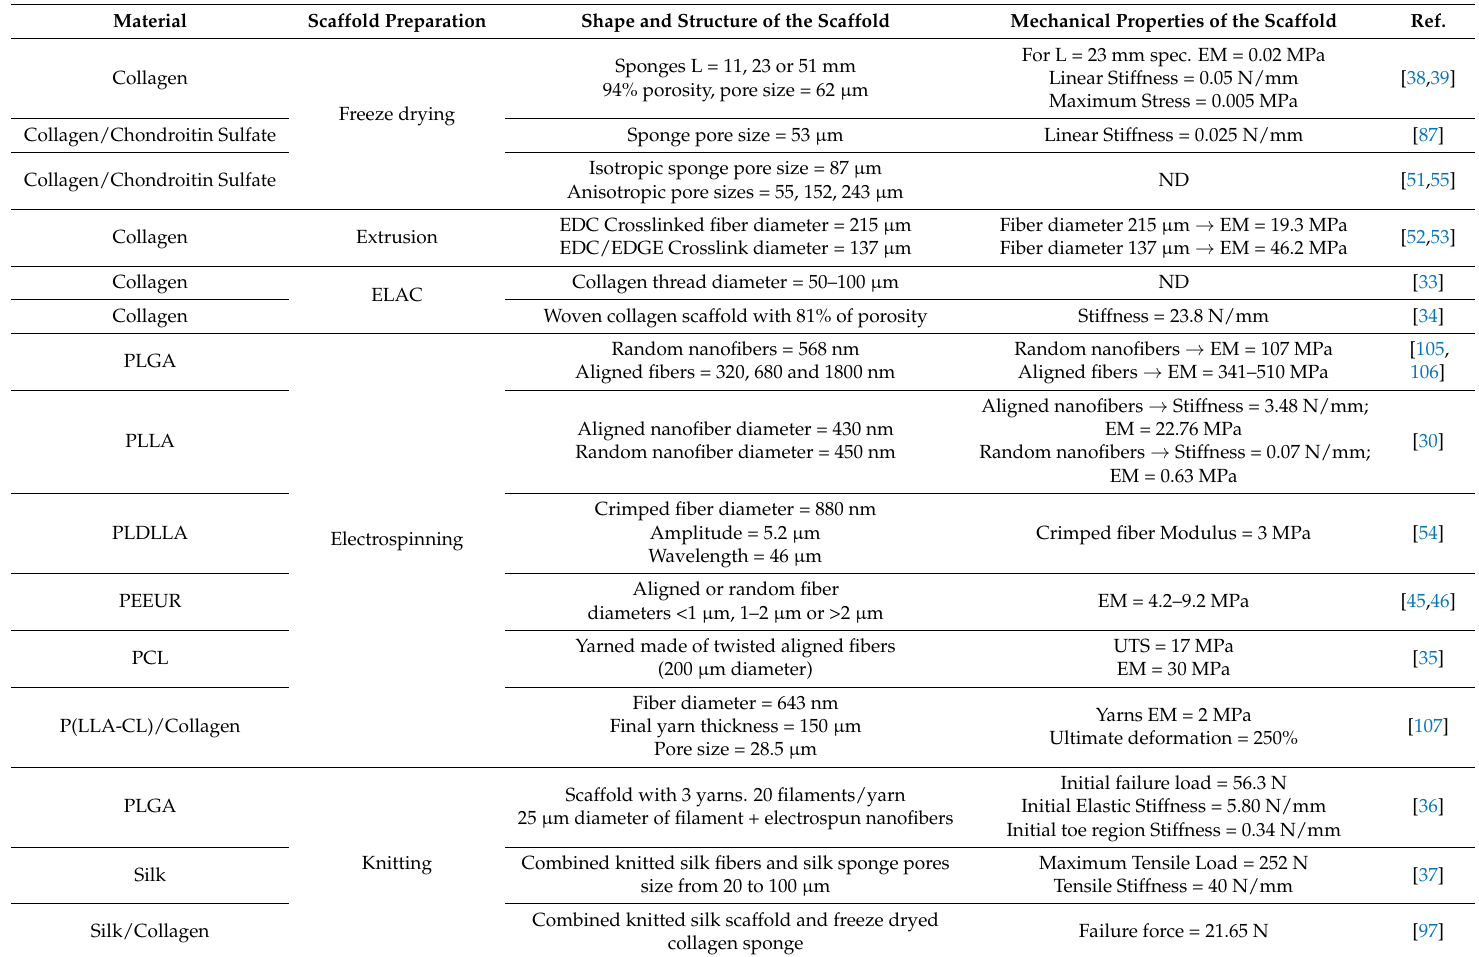
Table 1. Material characteristics for tendon tissue